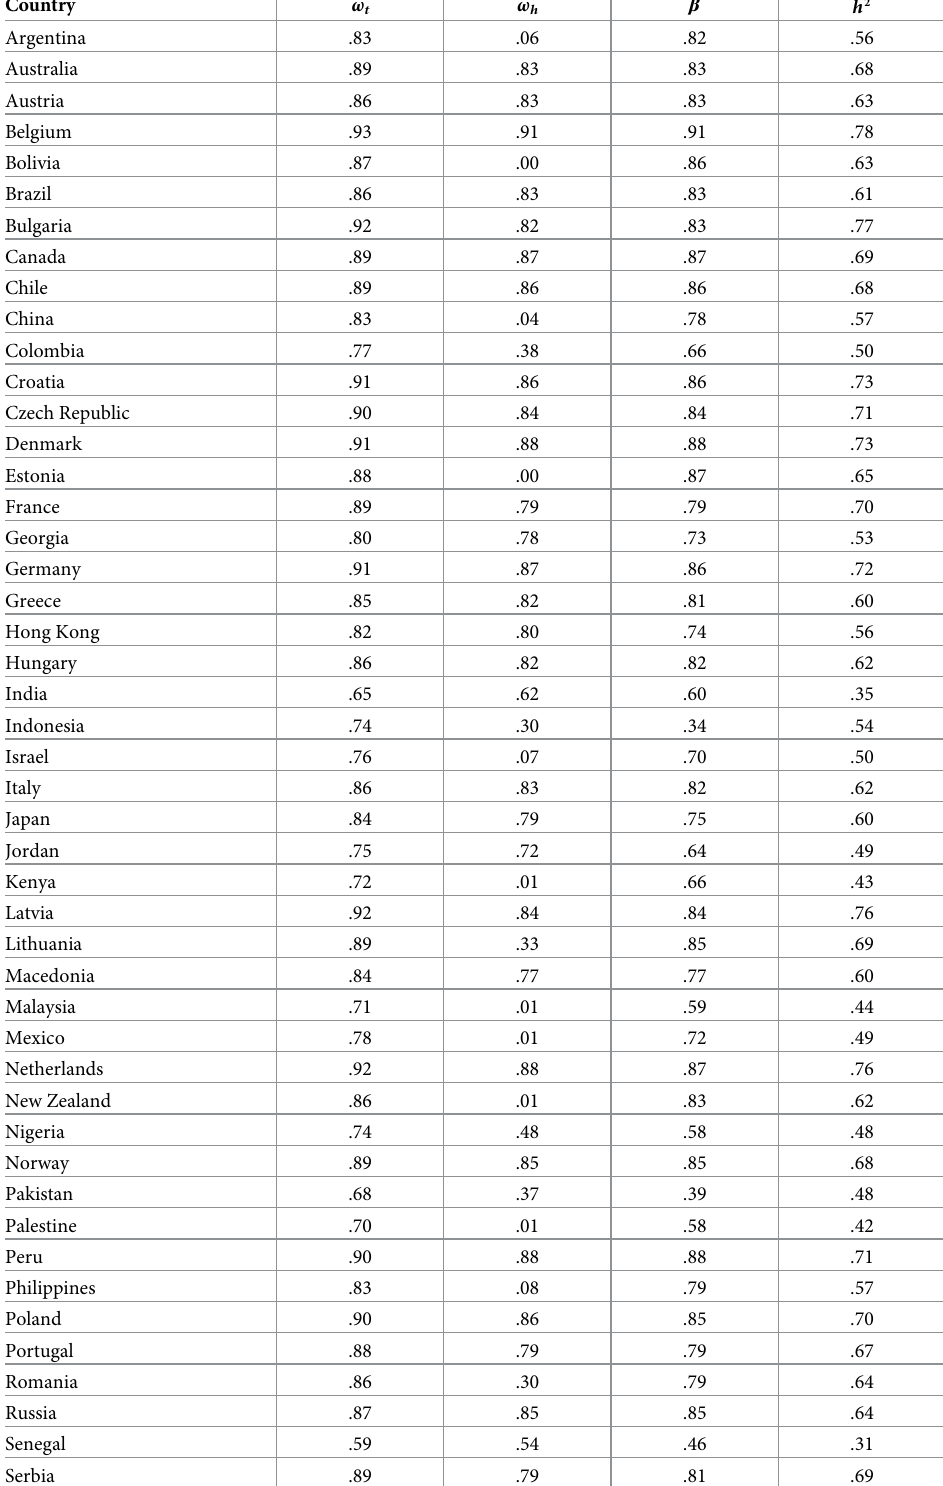
Table 2. Reliability measures of the Subjective Happiness Scale (SHS) by